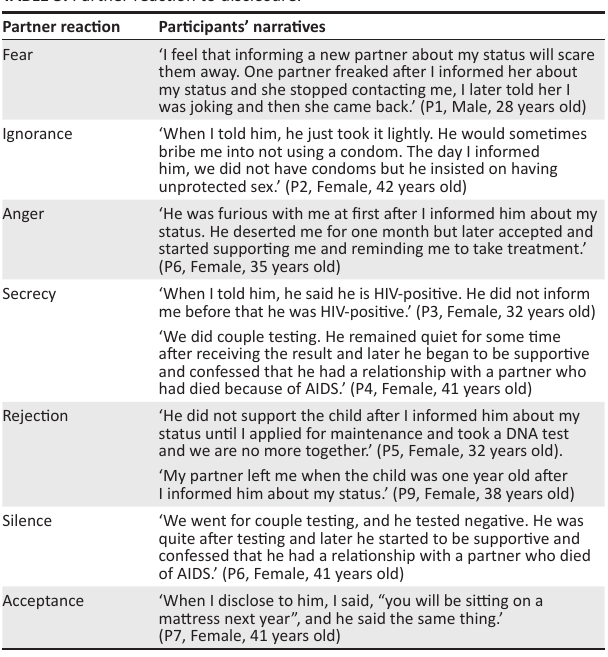
TABLE 3: Partner reaction to disclosure. Partner reaction Participants’ narratives